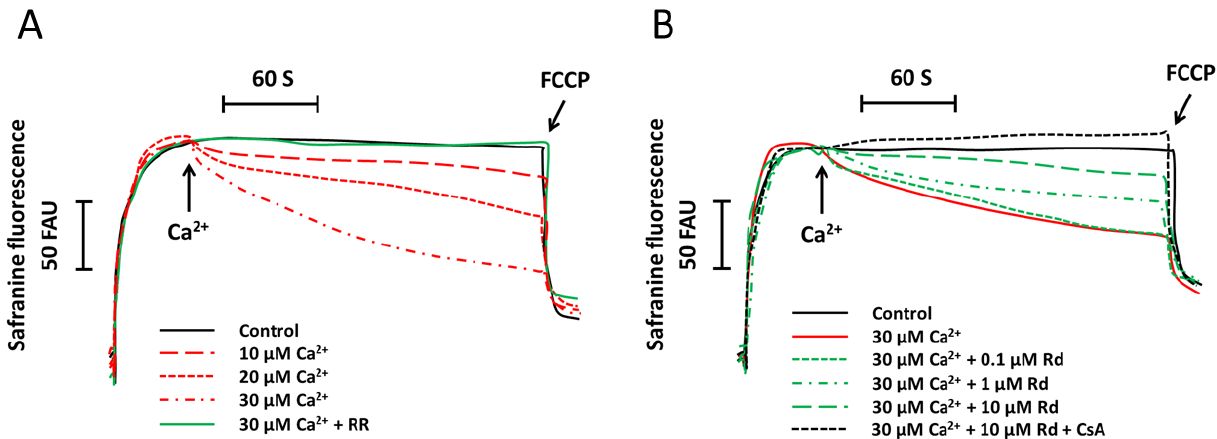
Figure 1. Rd (ginsenoside Rd) protects isolated spinal cord mitochondria against Ca 2+ induced mitochondrial membrane potential dissipation. ( A ) Isolated spinal cord mitochondria (0.5 mg protein/mL supported by succinate) were treated with or without 1 μM ruthenium (RR) for 60 s before the incubation with increasing concentrations of Ca 2+ (10, 20, or 30 μM). The mitochondrial membrane potential was measured up to 300 s; ( B ) Isolated spinal cord mitochondria (0.5 mg protein/mL supported by succinate) were treated with Rd at different concentrations (0.1, 1, or 10 μM) in the presence or absence of 1 μM cyclosporin A (CsA) for 60 s before the incubation with 30 μM Ca 2+ . The mitochondrial membrane potential was measured up to 300 s. Controls were performed in the absence of Ca 2+ , and 1 μM p -trifluoromethoxy-phenylhydrazone (FCCP) was added to induce maximal depolarization at the end of the measurements. Traces are representative of three independent experiments performed in duplicate and were expressed as fluorescence arbitrary units